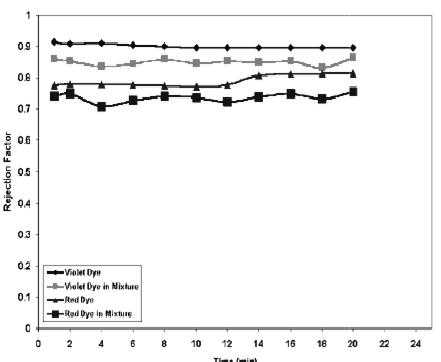
Fig.18. T The comparison of dyes (concentration es) with that o two dye